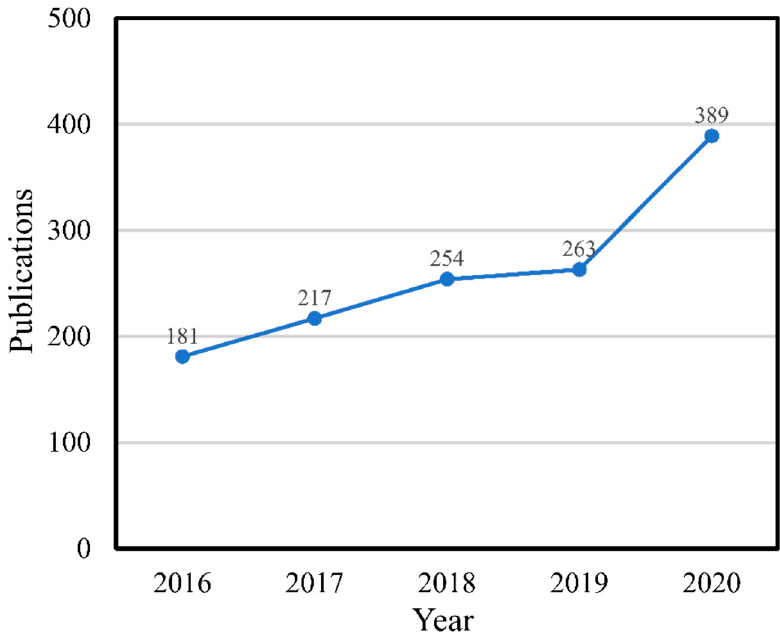
Figure 1. Trend of publications on Centella asiatica extraction from 2016–2020 in Scopus.